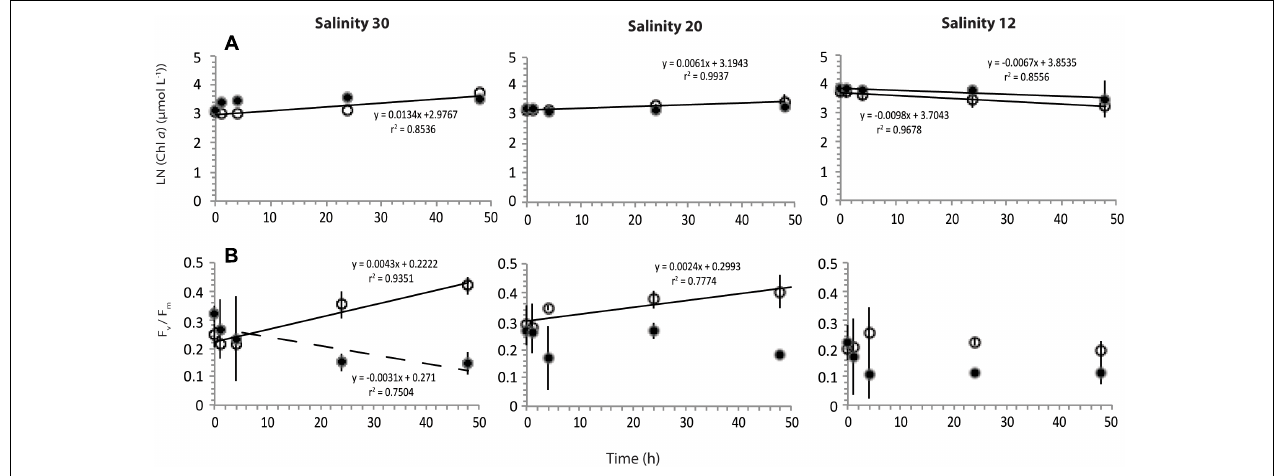
FIGURE 4 | Change in average ( n = 2) values with standard deviation of (A) LN transformed chlorophyll a (chl a ) and (B) maximum quantum efficiency of PSII (Fv/Fm) over time (hour) of cells in treatments of 30, 20, and 12 salinity, incubated under 30 (white) or 0 (black) µ mol m − 2 s − 1 light intensities. Linear regressions significant to p < 0.05 (solid) or p < 0.10 (dashed) with associated equations and coefficients of determination are also